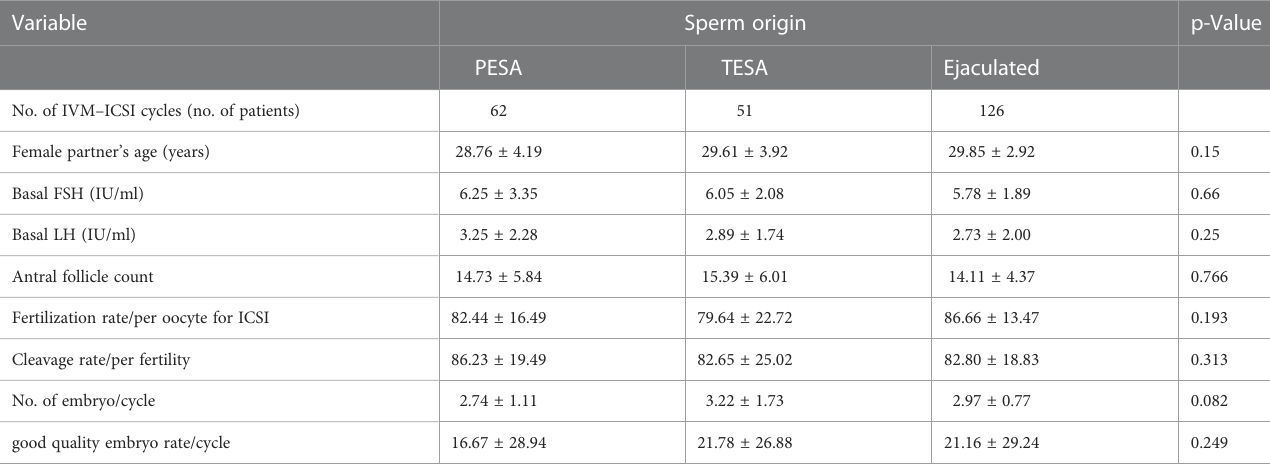
TABLE 1 Patient characteristics and embryology information of different sperm sources in IVM – ICSI cycle.